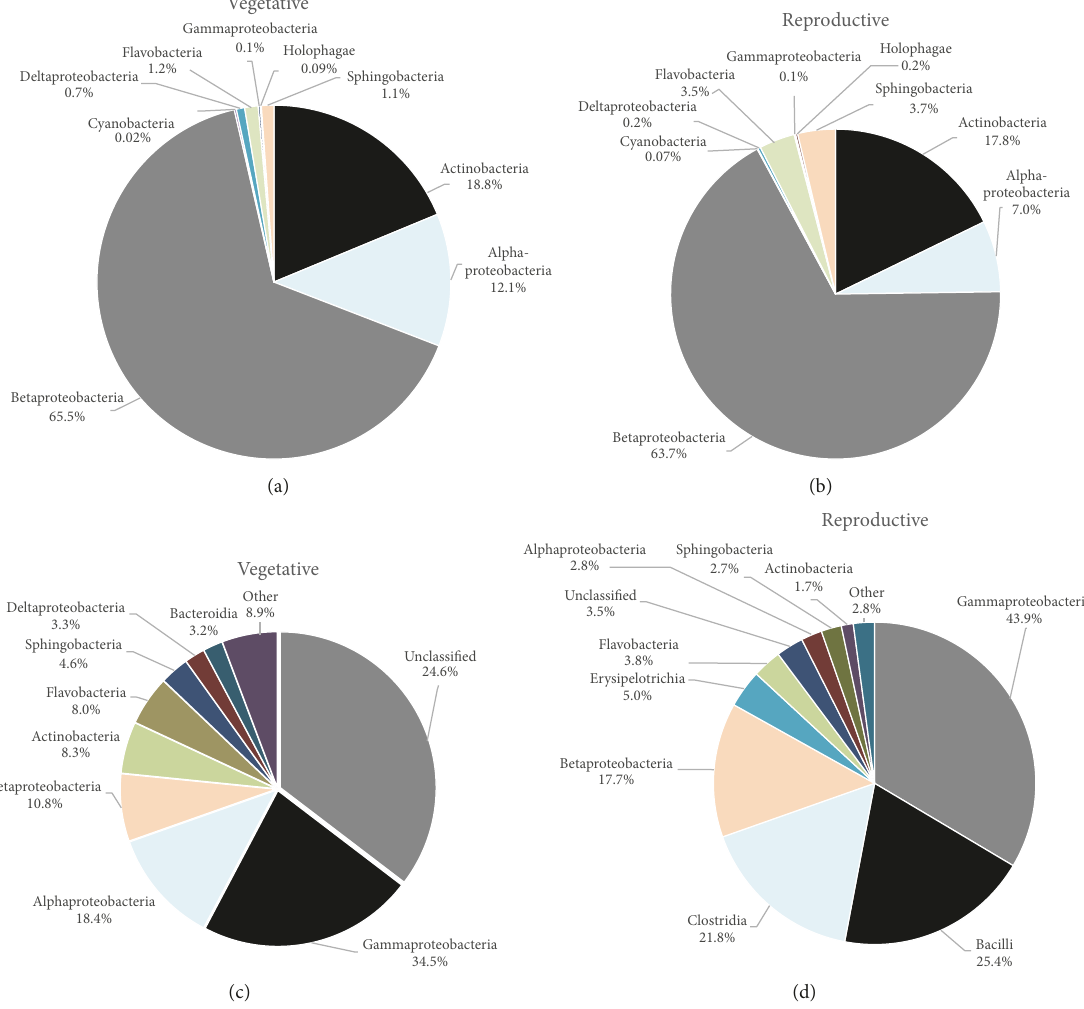
Figure 4: Relative abundances of class level assignments for the 88 shared OTUs in the vegetative stage (a) and reproductive stage (b) and relative abundances of the class level assignments of the 1463 OTUs unique to the vegetative stage (c) and the 515 OTUs unique to the reproductive stage (d). OTUs were taxonomically classified by the Wang method in mothur using an 80% confidence threshold for class level